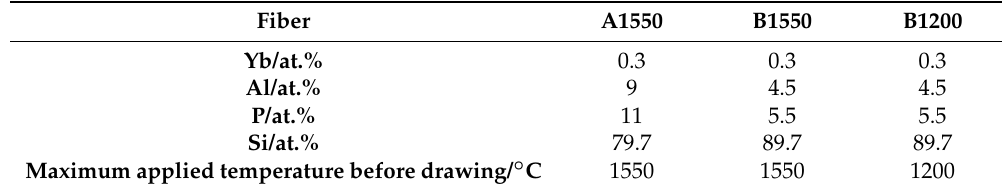
Table 1. Core precursor composition and maximum heat treatment temperature.